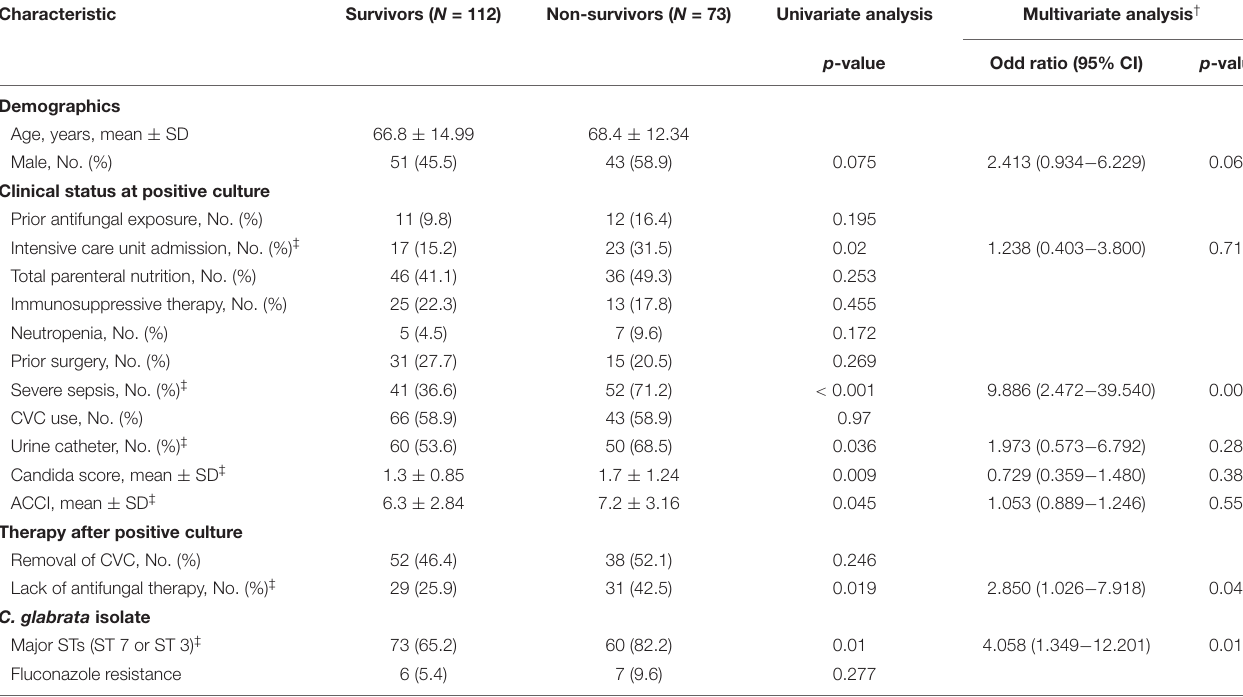
TABLE 4 | Univariate and multivariate logistic regression analyses of prognostic factors for 30-day mortality.